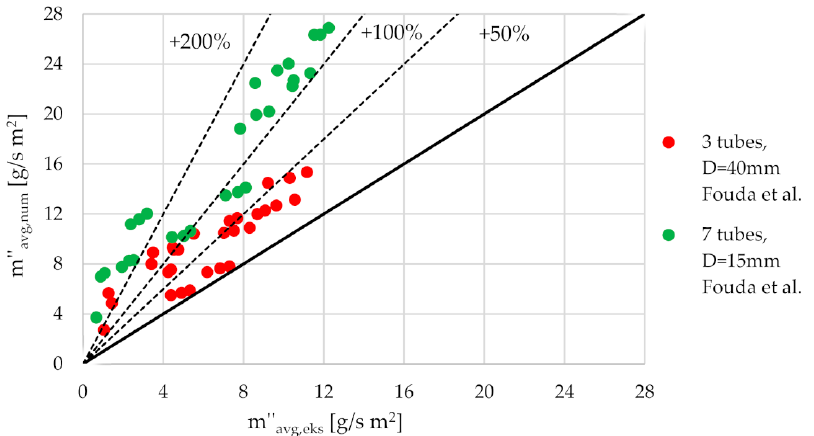
Figure 8. Comparison between experimental and calculated condensation mass fluxes, obtained using the existing model